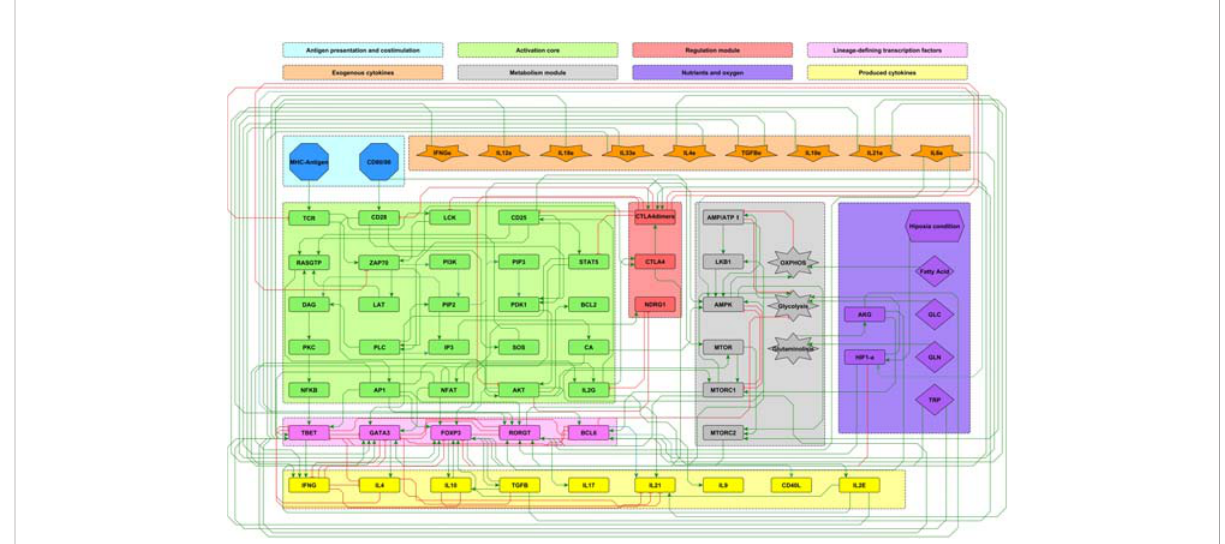
FIGURE 1 Modular 68-node network of early events in CD4 + T cell activation. Modules are described in the upper panel and their respective elements are indicated with the corresponding color in the network. Three modules correspond to inputs or entries of the system: antigen presentation and co-stimulation (blue), microenvironmental cytokines (orange), and nutrient and oxygen availability (purple). Four modules describe the intracellular interactions leading to activation and production of cytokines: an activation core (green), metabolic regulation including AMPK as the central regulator (grey), a regulatory module including the activity of CTLA-4 and the anergy factor NDRG1 (red), and the lineage-de fi ning transcription factors leading to the production of speci fi c cytokines de fi ning the effector phenotypes Th1, Th2, Th17, T FH and Treg (pink). Finally, another module includes the output cytokines produced by differentiated cells (yellow). Green and red edges represent activator and inhibitory pathways, respectively. The set of interacting fuzzy logic rules de fi ning the dynamical system is shown in Supplementary Material 1. Construction of the network can be consulted in (10). The complete set of ordinary differential equations is provided in Supplementary Material 2. An interactive network fi le can be consulted online in https://bit.ly/3ar1Ojp. AKG, a -keto glutarate; GLC, glucose; GLN, glutamine; TRP, tryptophan; HIF1- a , hypoxia-inducible factor